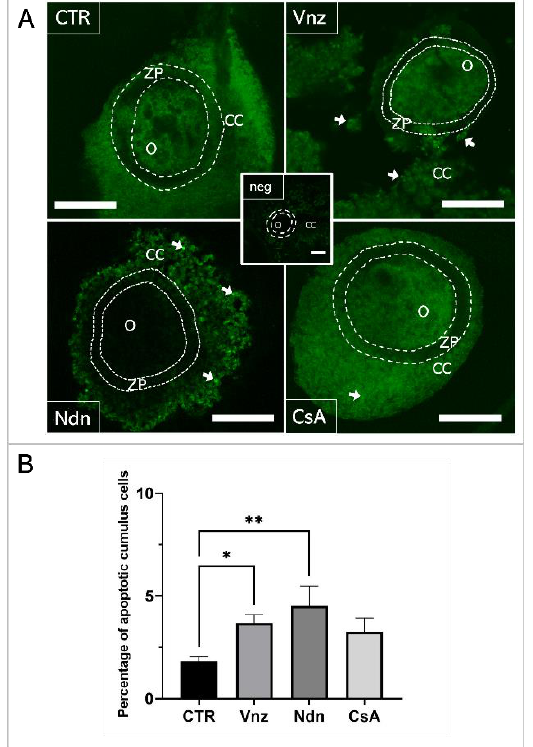
Figure 1. ( A ): TUNEL assay-mediated identification of the localization of late-apoptotic cells in porcine COCs subjected to the IVM procedure using a 3D culture model (alginate capsules). Representative images of COCs stemming from control (CTR) and experimental groups of 3D-IVM: in the presence of vinclozolin (Vnz), nandrolone (Ndn) or cyclosporin A (CsA). The contours of the oocytes are marked with dashed lines. White arrows indicate TUNEL-positive late-apoptotic cumulus cells (CCs) that fluoresced in bright green. A negative control was performed without active terminal deoxynucleotidyl transferase (TdT) enzyme (neg). O: oocyte; ZP: zona pellucida. All scale bars represent 100 μm (magnification 40×). ( B ): The results of the semi-quantitative TUNEL analysis. The results represent the mean value with n = 9 ± standard deviation (SD) for all experimental groups. Statistical analysis: homogeneity of variance—Brown–Forsythe test; normality of distribution—Bartlett’s test and one-way ANOVA followed by Dunnett’s post hoc test, * p < 0.05, ** p <